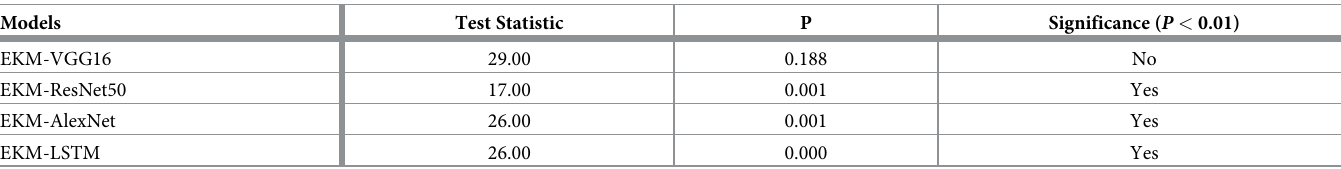
Table 5. Statistical significance tests for Experiment